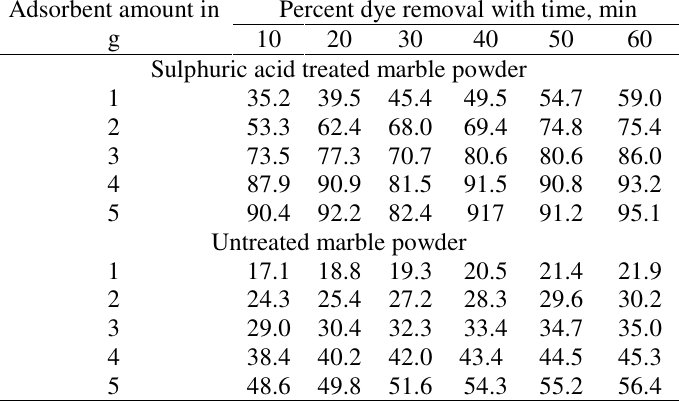
Table 4. Effect of adsorbent dose on the dye